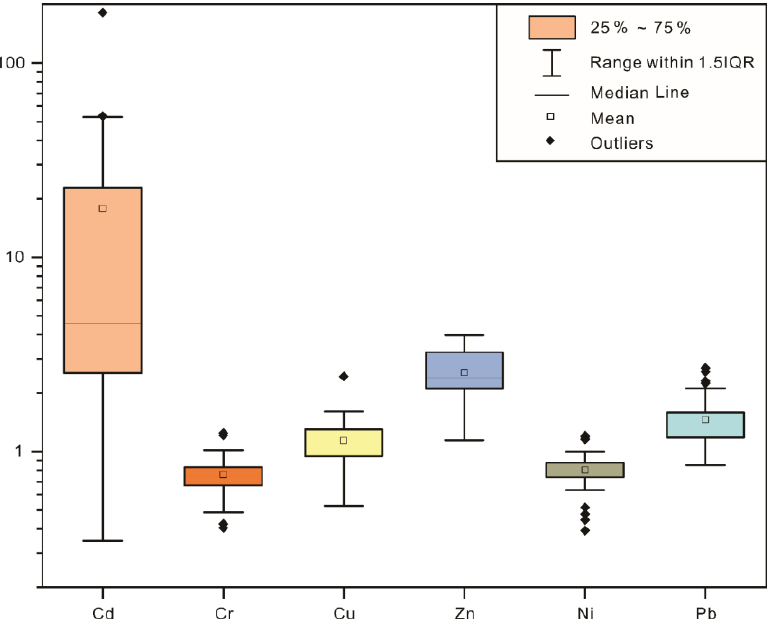
Figure 3. Box diagram of the distribution of metal enrichment factors in soil.